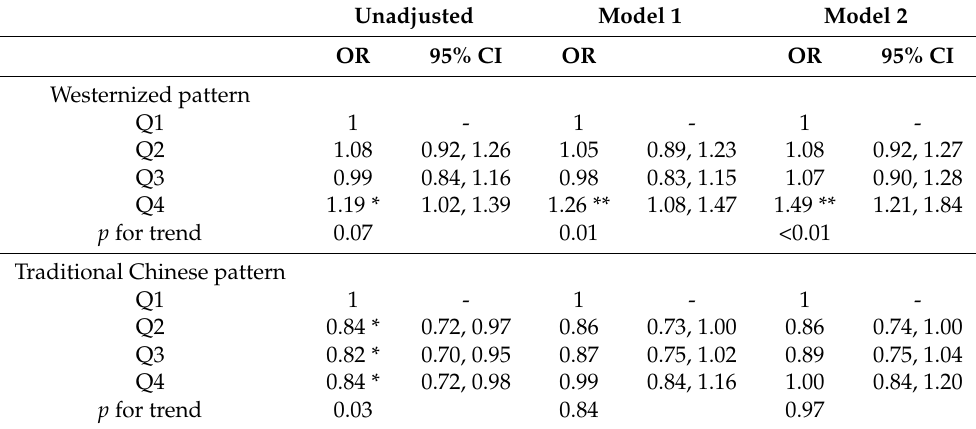
Table 5. Association of dietary patterns with childhood obesity in China (odds ratios and 95% confidence